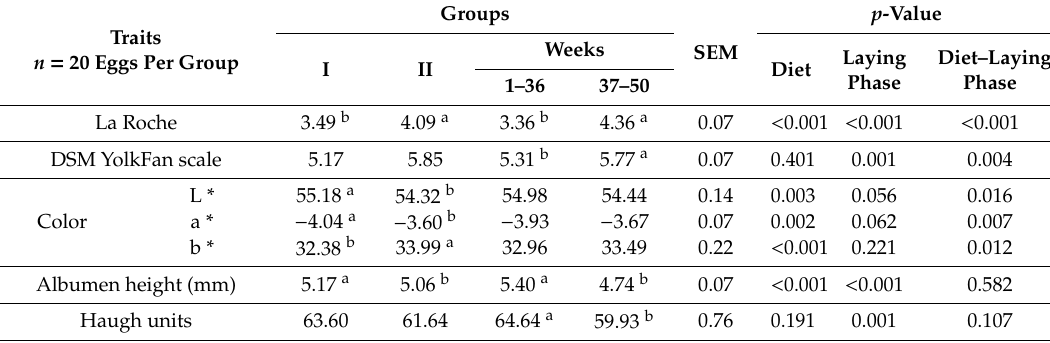
Table 8. Parameters of egg